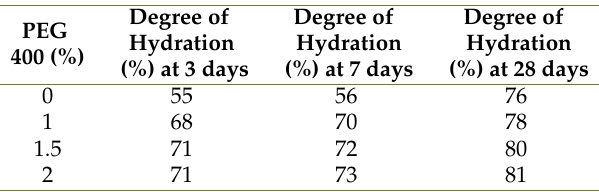
Fig. 4. Degree of Hydration Values at 0.34 Water-Cement Ratio. Table 4. Degree of Hydration at 0.55 Water-Cement Ratio.